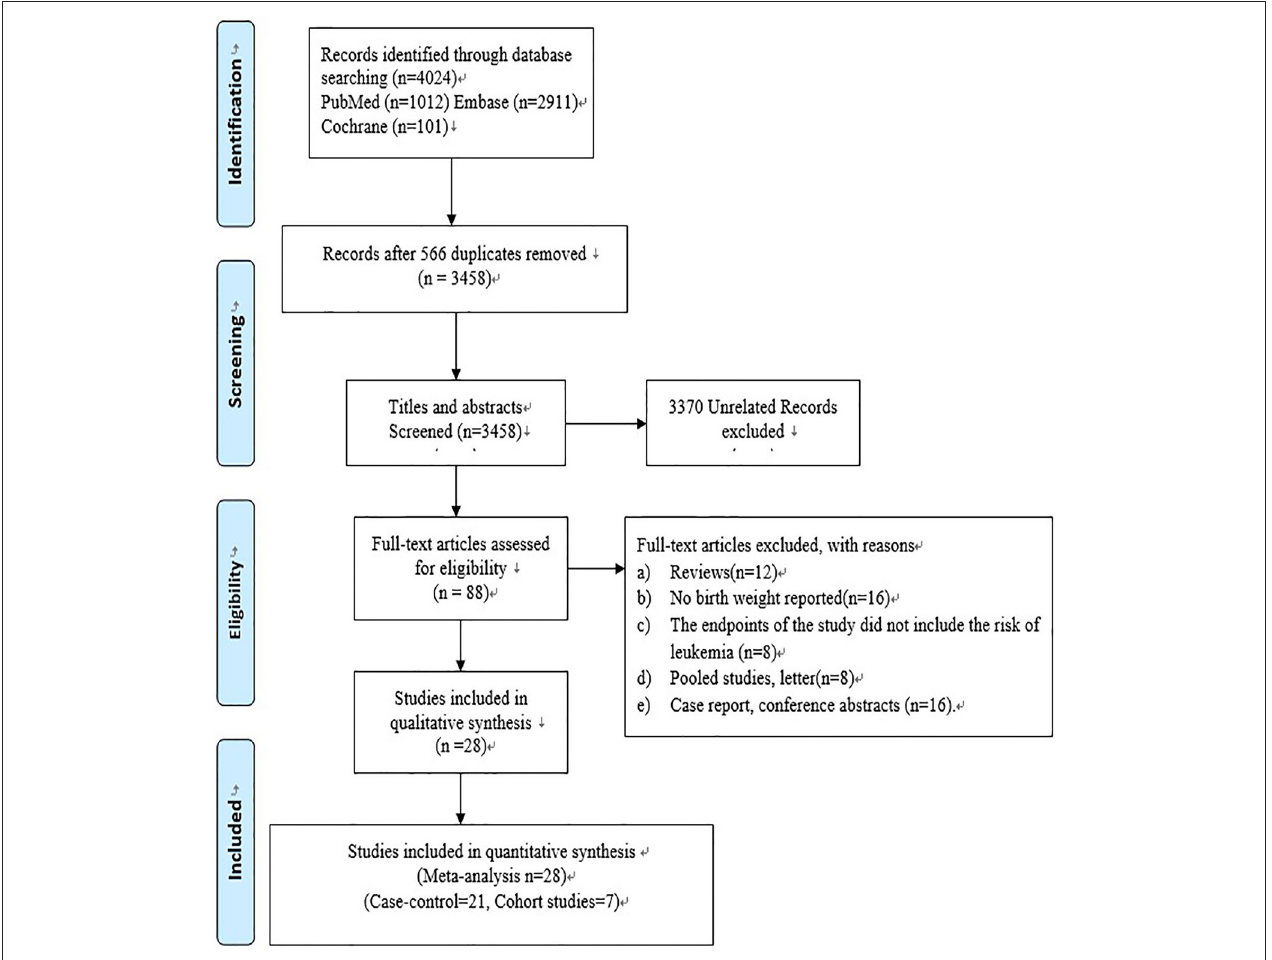
FIGURE 1 | Flow chart of search results.